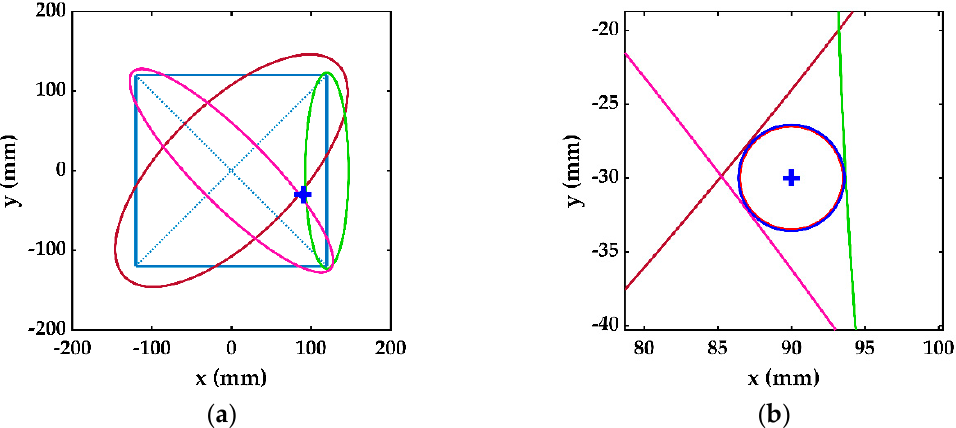
Figure 13. ( a ) Three corner ellipses in the third-stage damage detection. ( b ) Estimated (blue) and actual (red) damage.